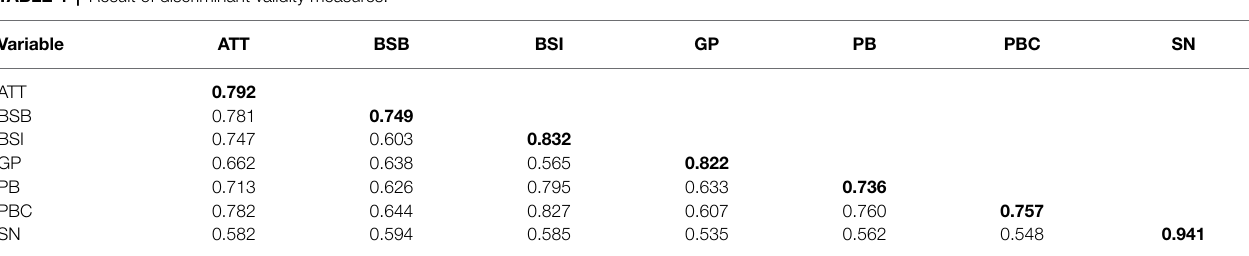
TABLE 4 | Result of discriminant validity measures.